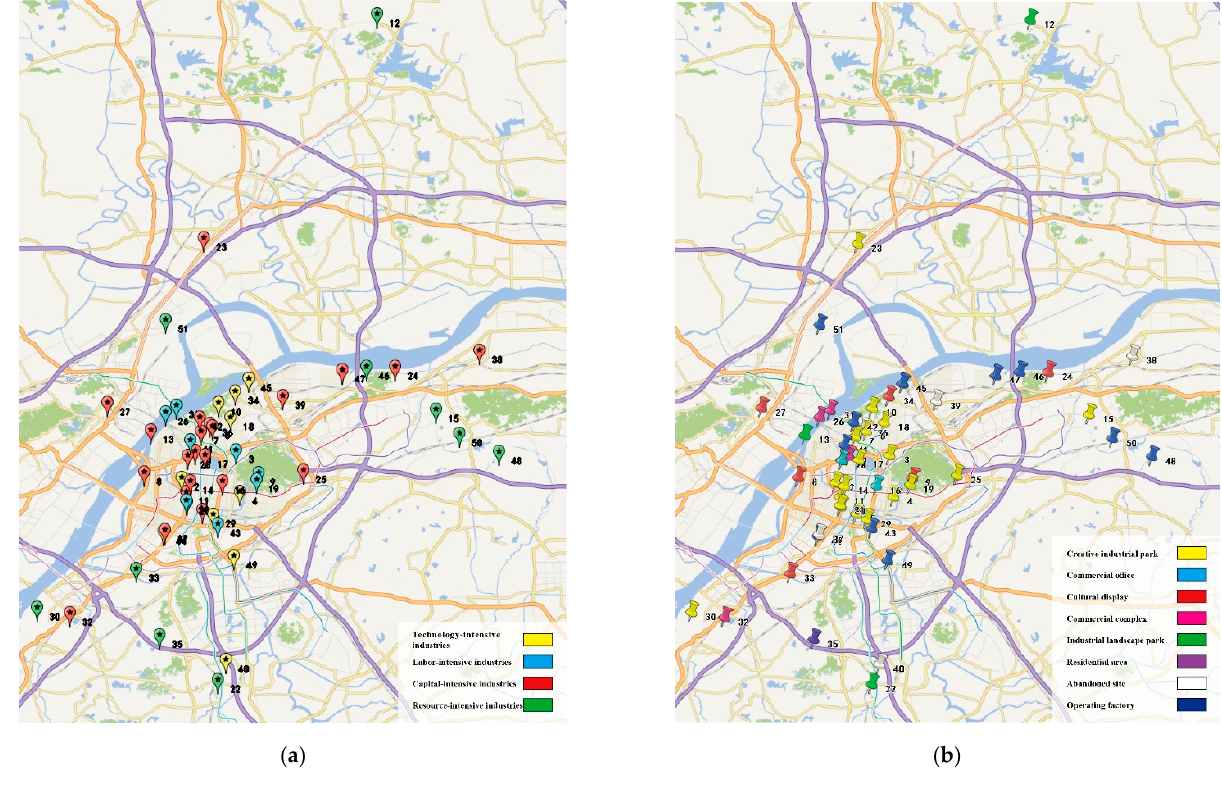
Figure 32. The original industry types and reuse status of the 51 industrial heritage sites in Nanjing: ( a ) distribution of industrial types of 51 industrial heritage sites in Nanjing; ( b ) reuse status of 51 industrial heritage sites in Nanjing (Figure source: own drawing; data source: on-site investigation and interview).